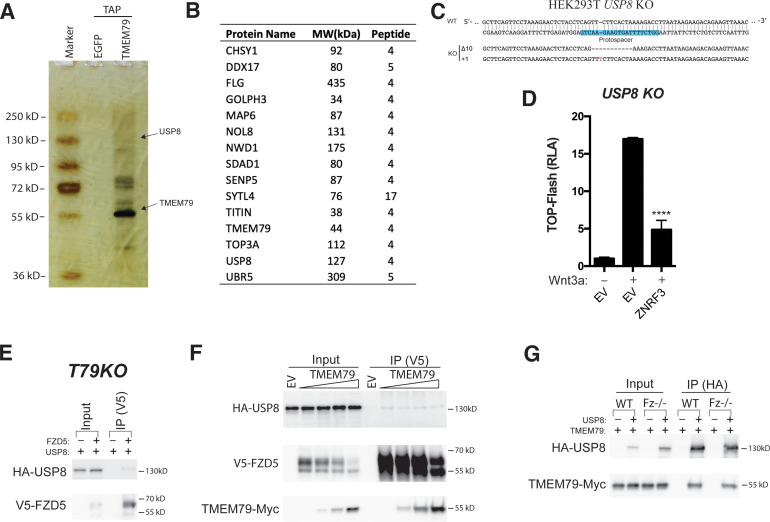
Tandem affinity purification-coupled mass spectrometry identifies USP8 as a TMEM79 binding partner.(A) Tandem affinity purified proteins were resolved by SDS-PAGE and visualized by silver staining. The same tandem IP procedure of EGFP-expressing cell extracts serves as a negative control. The TMEM79 bait protein is marked, as is the gel fraction that corresponds to the molecular weight of USP8. (B) List of candidate proteins from tandem affinity purification-coupled mass spectrometry. Note that only a few visible fractions/bands in A were excised and pooled together for mass spectrometry analyses (see Materials and methods). The list is therefore not intended to be a comprehensive representation of all candidate TMEM79-associated proteins. (C) Genomic DNA sequencing showing indel (frame shift) mutations of USP8 alleles in a USP8 KO clone picked/used. Two clones were picked and tested with indistinguishable results (data not shown). (D) ZNRF3 inhibits top-flash reporter activity effectively in USP8 KO cells. (E) FZD5 co-IPs USP8 in the absence of TMEM79 in T79KO cells. (F) Overexpression of TMEM79 does not affect FZD5 co-IP of USP8. This experiment largely rules out a scenario that TMEM79 inhibits USP8 deubiquitination of FZD5 by competing with FZD5 for USP8. TMEM79 is also co-IPed by FZD5. (G) USP8 co-IPs TMEM79 in in FZD null cells.Figure 5—figure supplement 1—source data 1.Raw data for Figure 5—figure supplement 1.